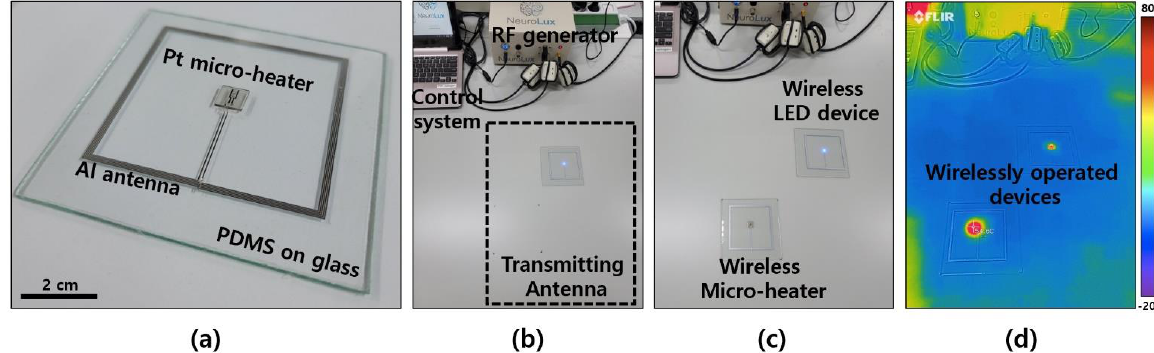
Figure 2. Wireless micro – heater and NFC – based power transfer system. ( a ) Wireless micro-heater device on a PDMS/glass substrate. ( b ) The wireless power transfer system consists of a RF generator, a control system, and a transmitting antenna. In ( c ) and ( d ) are a photograph and an IR image of wirelessly operated LED and micro-heater devices, respectively.